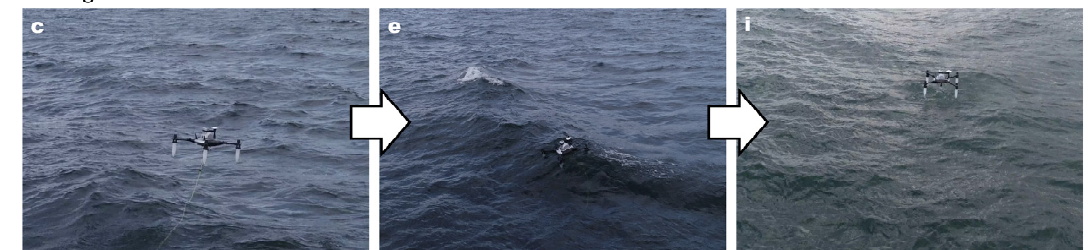
Figure 7. Enlarged snapshots of UAV operation: (c), (e), and (i) in Figure 6.